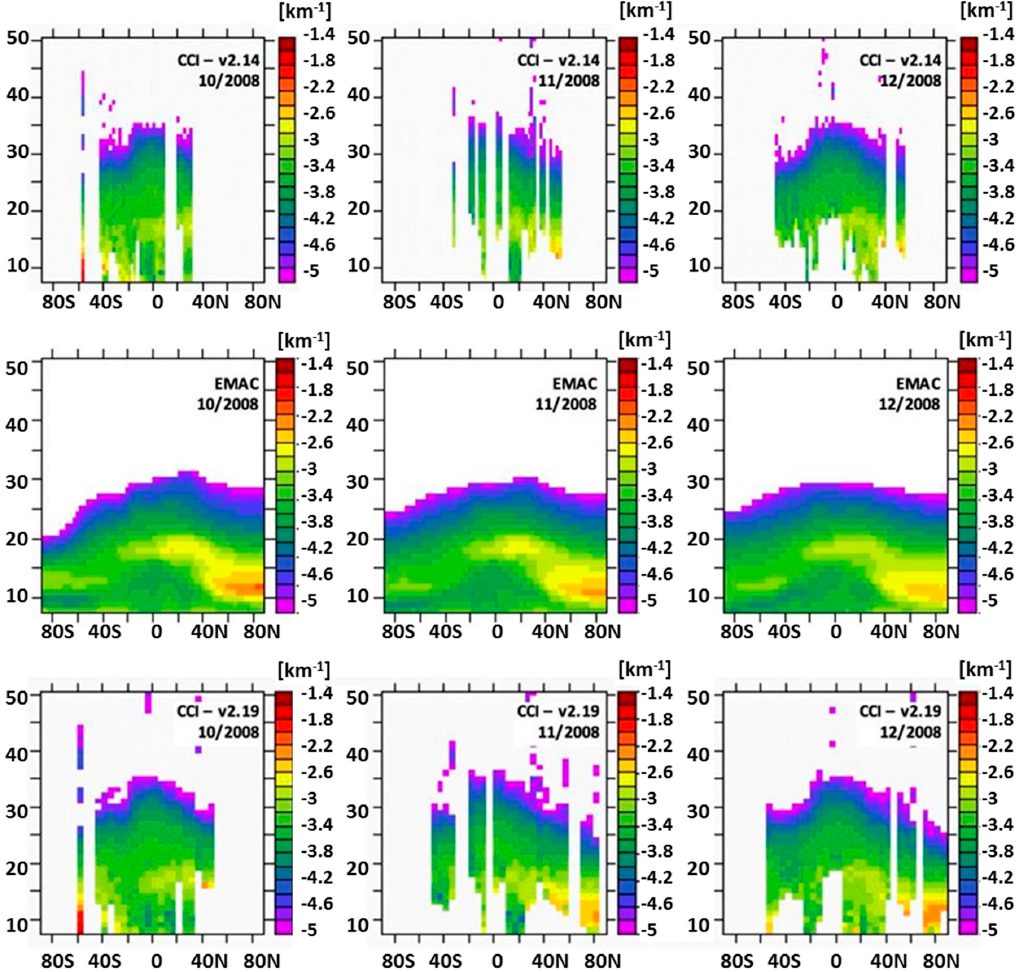
Figure 13. Zonally averaged stratospheric extinction at 550 nm for 3 months in 2008 (scaled in power of 10): upper row GOMOS (Global Ozone Monitoring by Occultation of Stars) version 2.14 dataset with monthly resolution, center row simulation by the EMAC model, lower row GOMOS version 2.19 dataset with 5-day resolution This period was impacted by the Kasatochi eruption (52°N, 176°W) in August of that year.